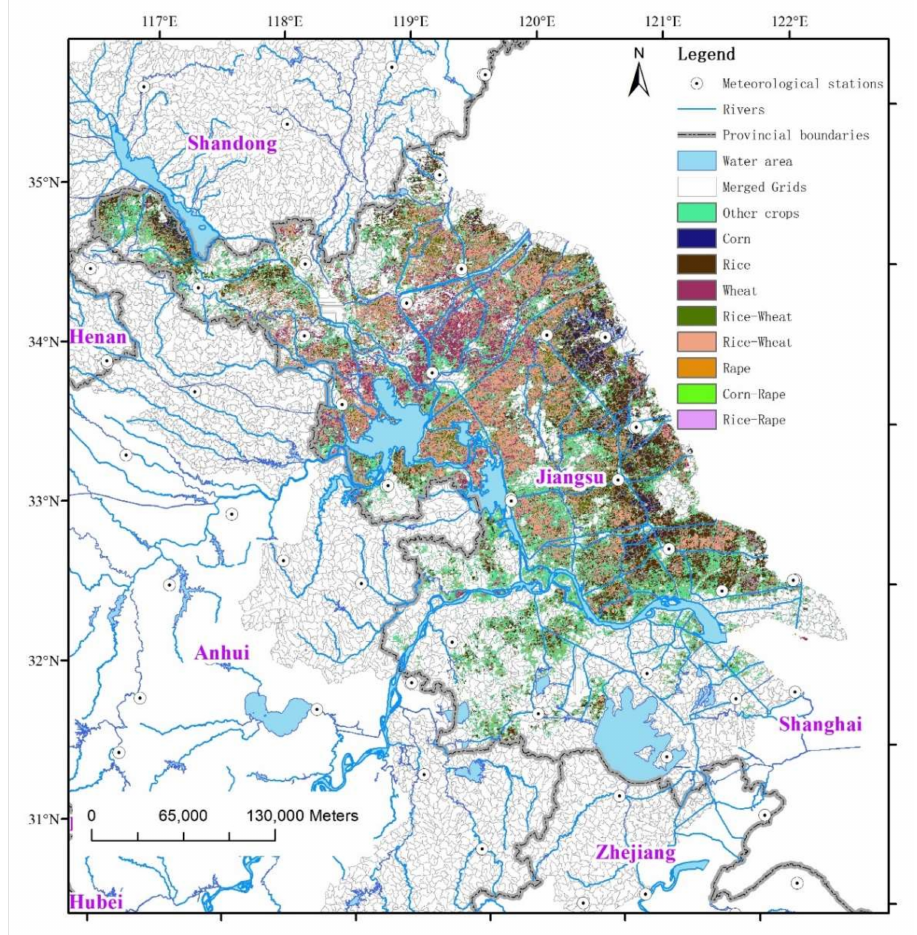
Figure 2. Spatial distribution diagram of meteorological stations, water area, and crop rotation types in Jiangsu